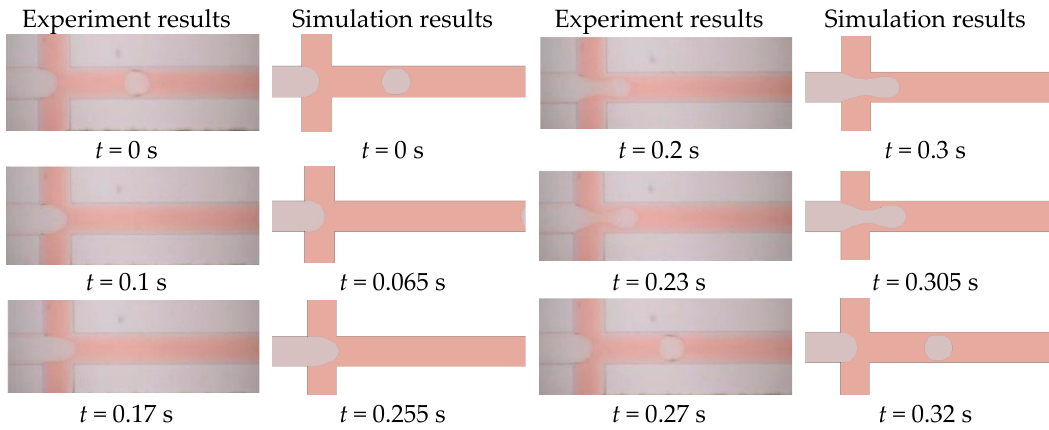
Figure 2. Comparisons of the droplet formation process between the experiment results by Cao et al. [22] and the simulation results. Q d = 1 mL/h, Q c = 20 mL/h.